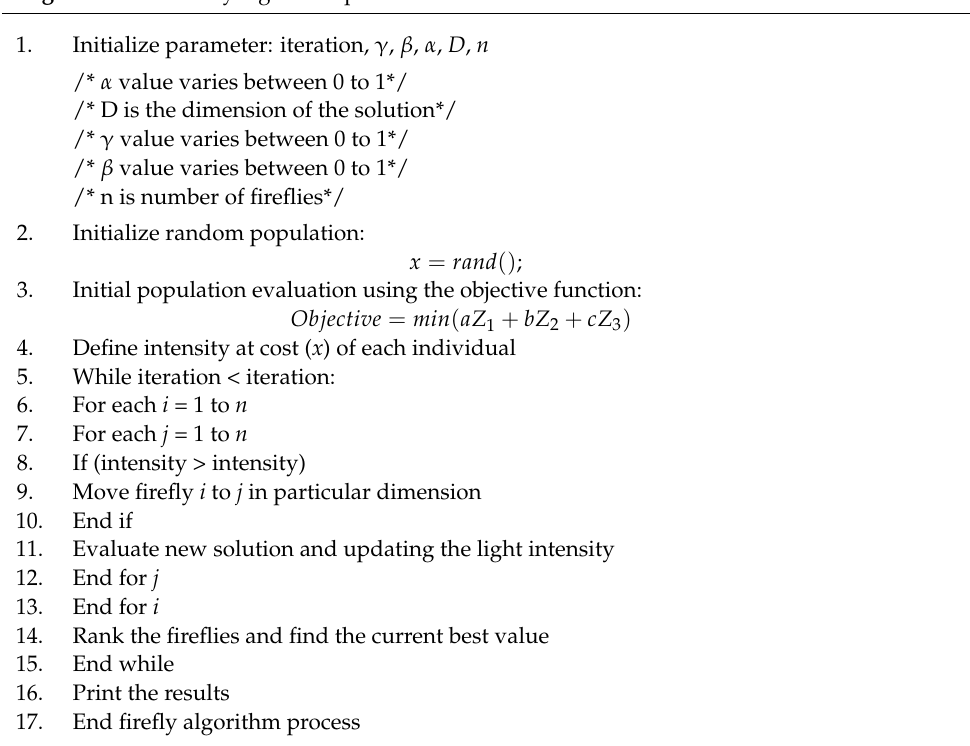
Algorithm A1: Firefly algorithm